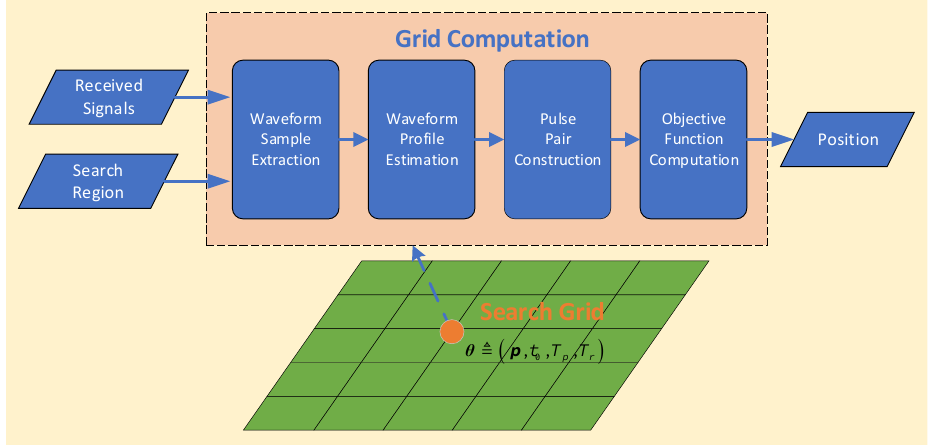
Figure 2. A flow graph for direct position determination (DPD)-waveform estimation (WE) algorithm Based on grid